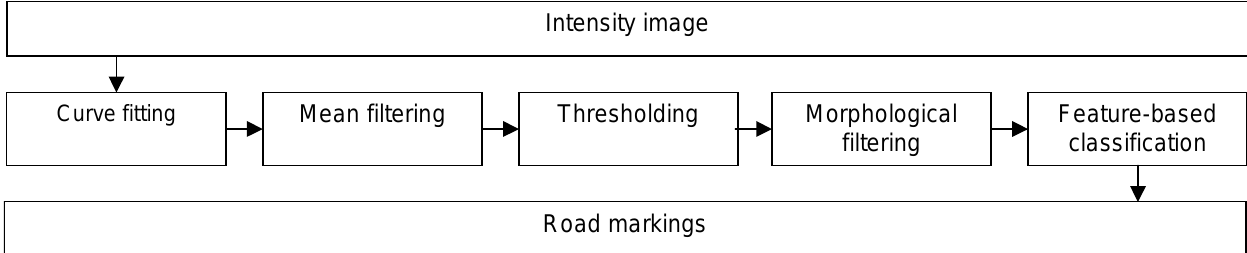
Figure 2. Modelling process of the road markings.